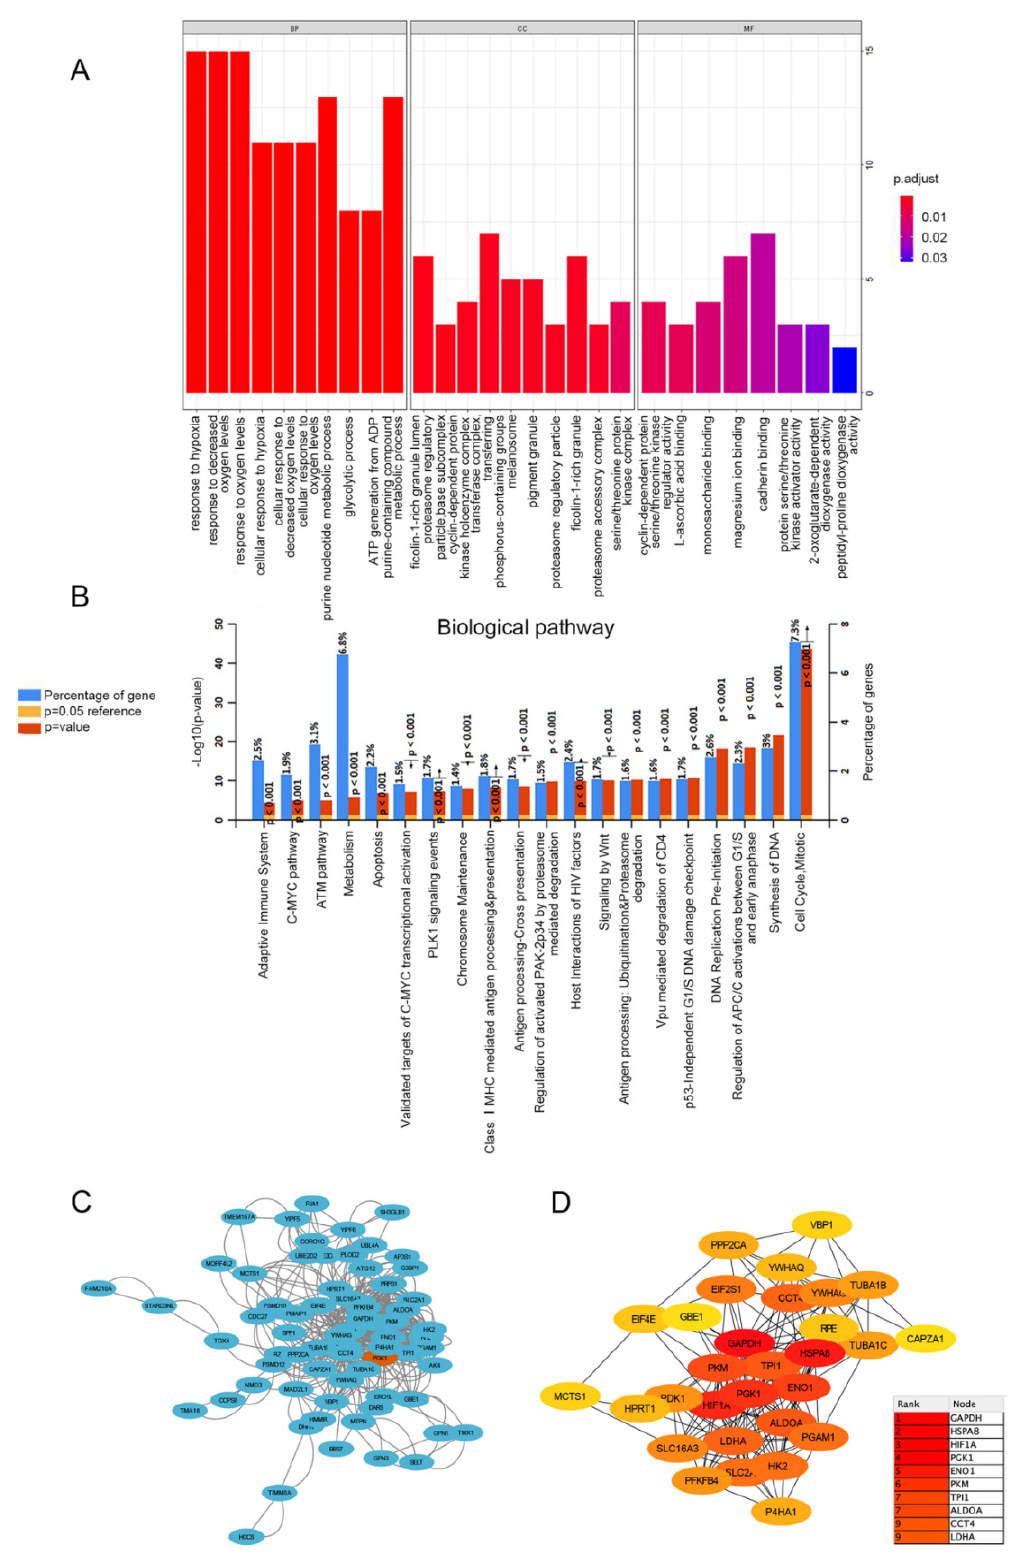
Figure 3. Functionally annotated PGK1 co-expression module. Top 100 GO annotation ( A ) and KEGG pathway terms ( B ). Cytoscape was used to build the PPI network of co-expressed genes ( C ). The most important module was acquired from the PPI network, which included 30 nodes and 172 edges ( D ).